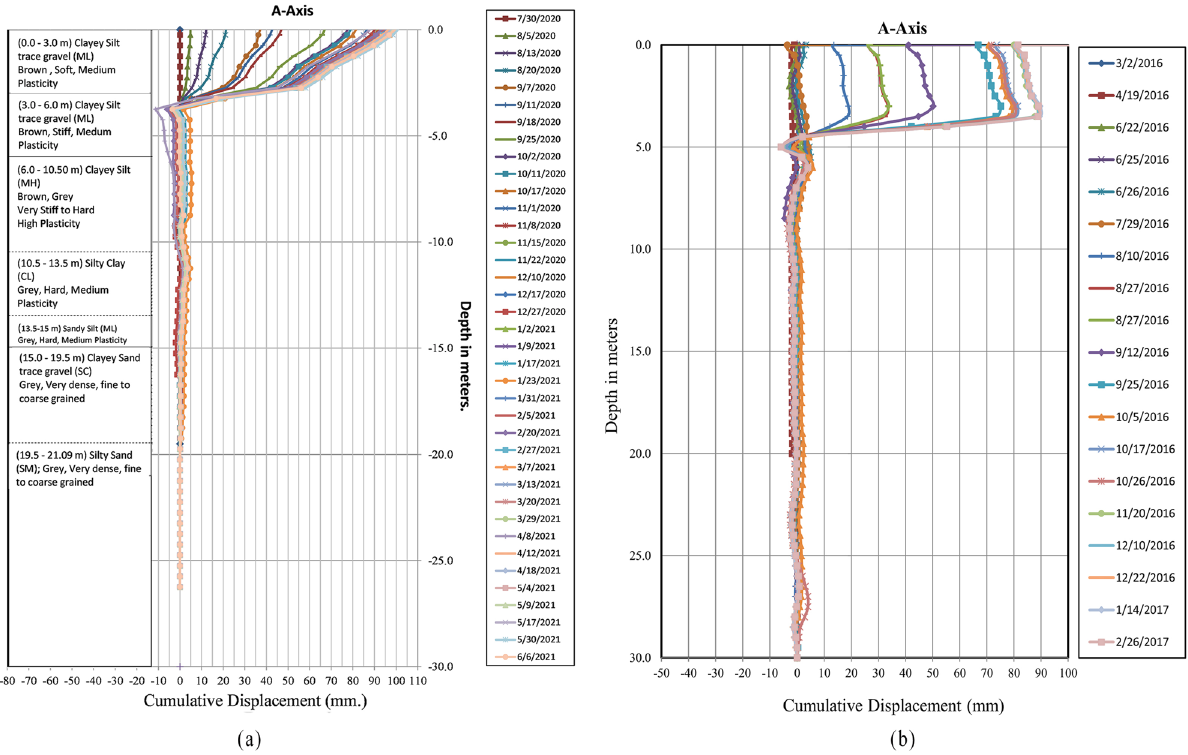
Figure. 3. ( a ) Orientation of inclinometer in 2016 ( b ) Observation of inclinometer in